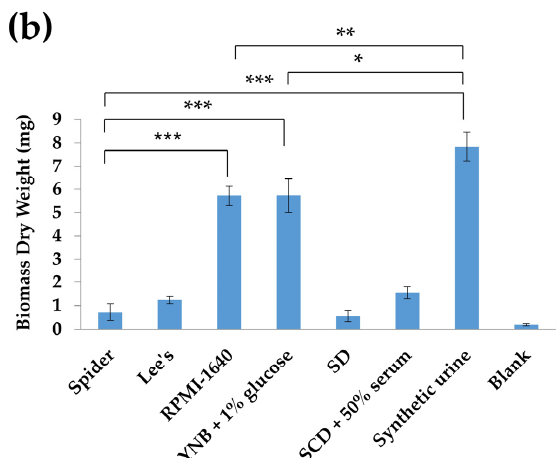
Figure 2. RPMI, YNB + 1% glucose, and synthetic urine (SU) media as adhesion conditions exhibited